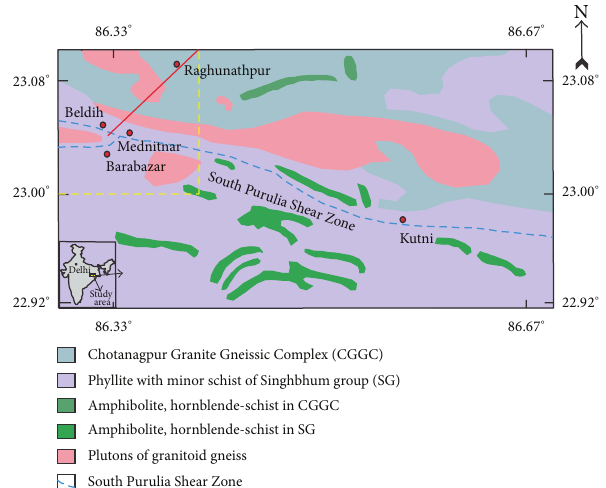
Figure 1: Geological map of the study area (after [10]) with gravity survey area (dotted yellow) and sounding profile line